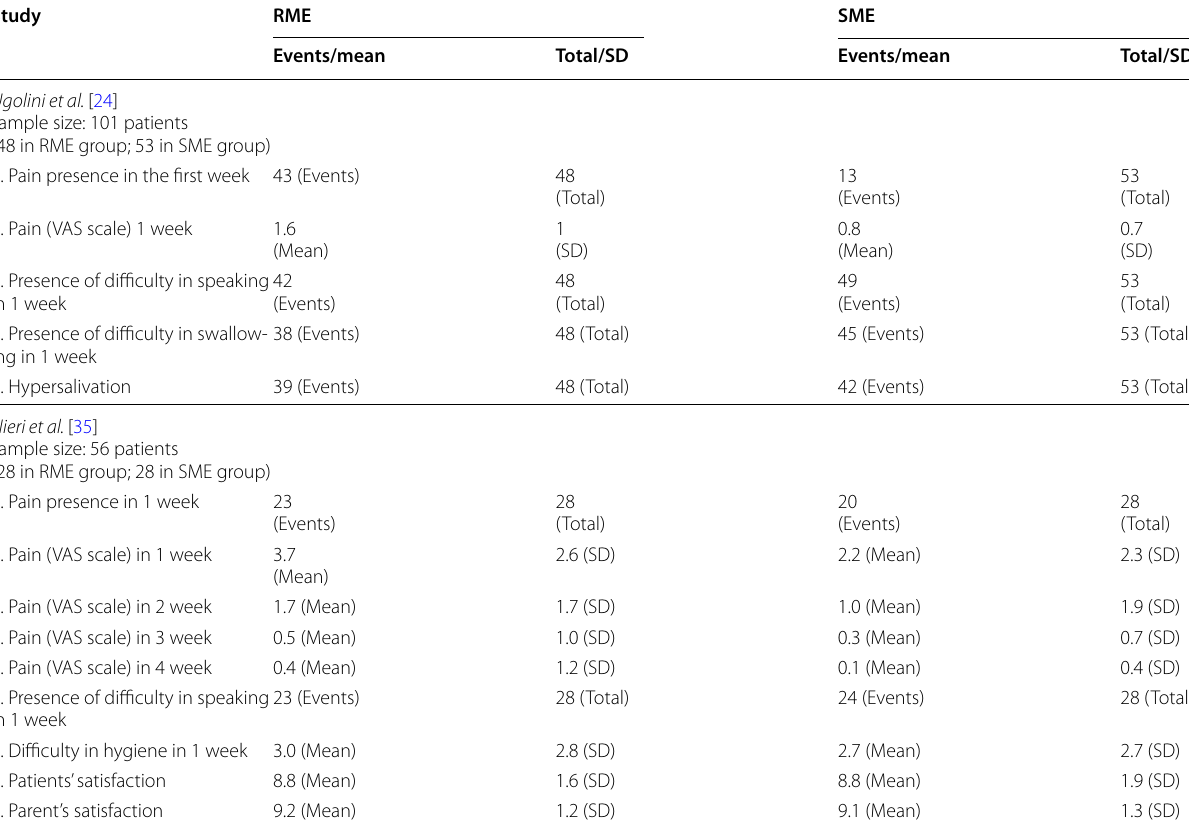
Table 6 Comparison between patient-related outcomes produced by RME versus SME in included studies in the systematic review Study RME SME Events/mean Total/SD